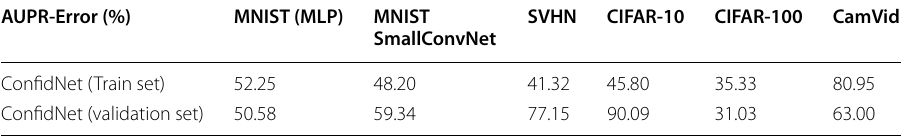
Table 3 ConfidNet comparison on validation and training